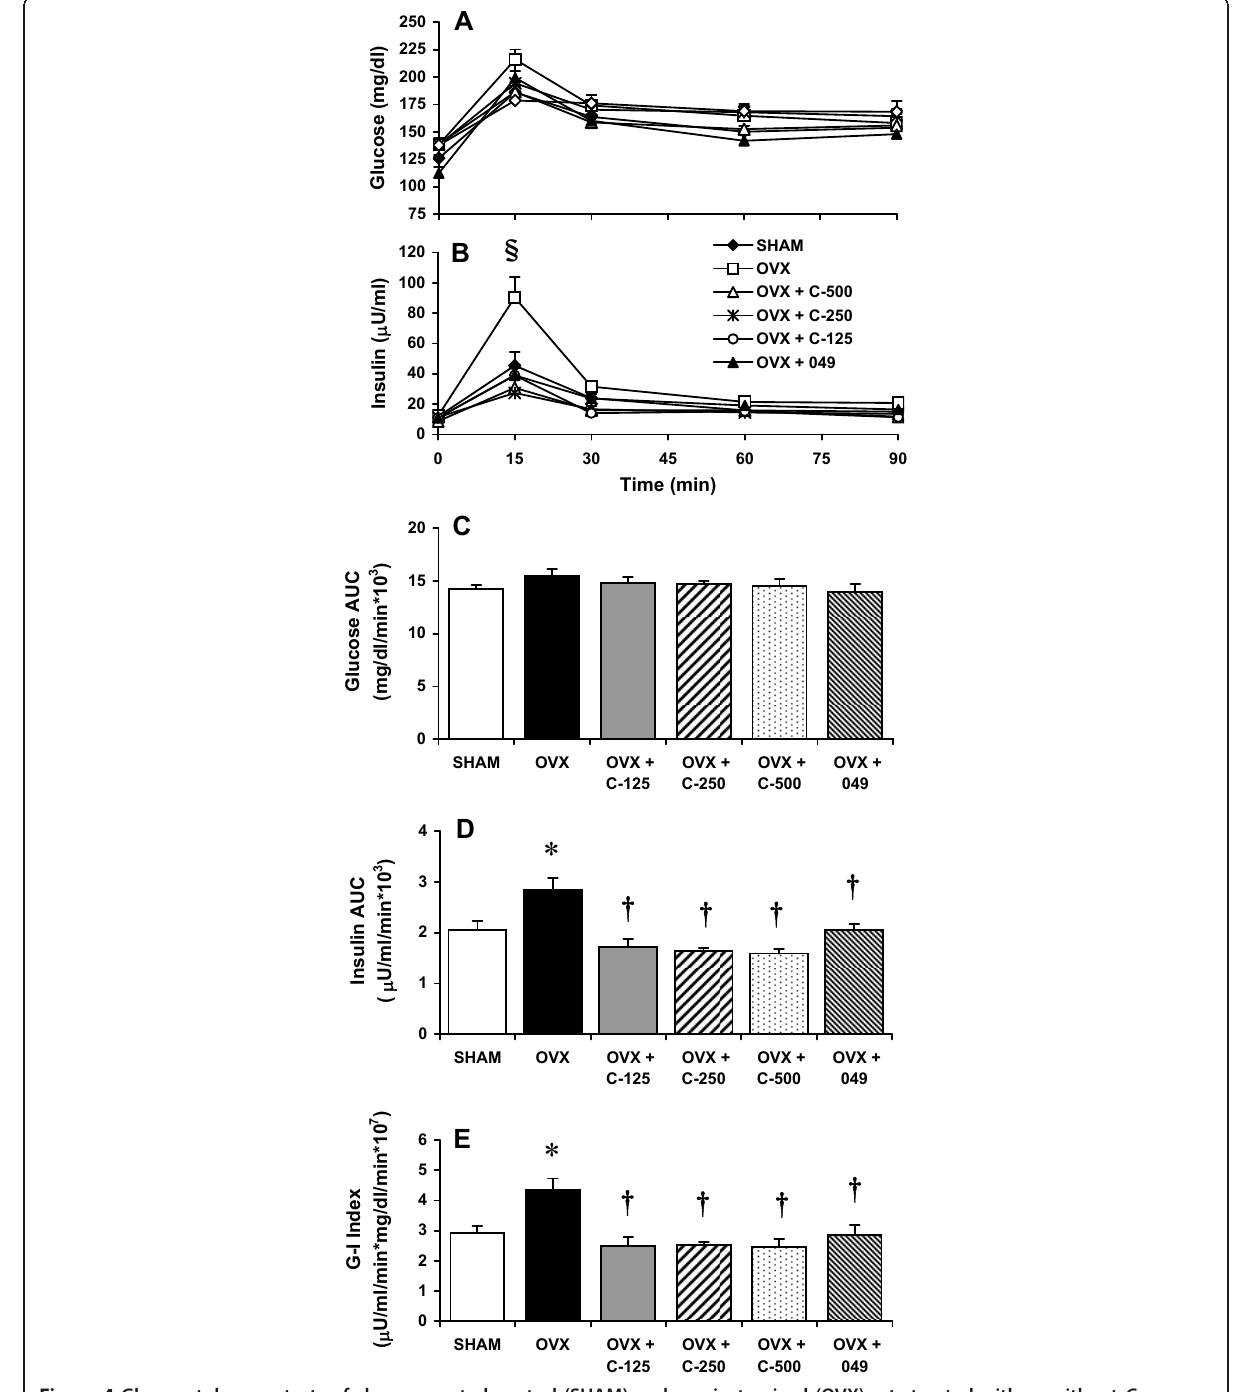
Figure 4 Glucose tolerance tests of sham operated control (SHAM) and ovariectomized (OVX) rats treated with or without C. comosa hexane extract or compound 049 . Animals are as described in legend of Figure 2. Glucose (A) and insulin (B) responses; area under the curve (AUC) for glucose (C) and insulin (D); glucose-insulin (G-I) index (E). G-I index is the product of glucose AUC and insulin AUC for each individual animal. Values are reported as the mean ± SE for 7-8 animals/group. * P < 0.05 vs. SHAM group; † P < 0.05 vs. OVX group; § P < 0.05 vs. all other